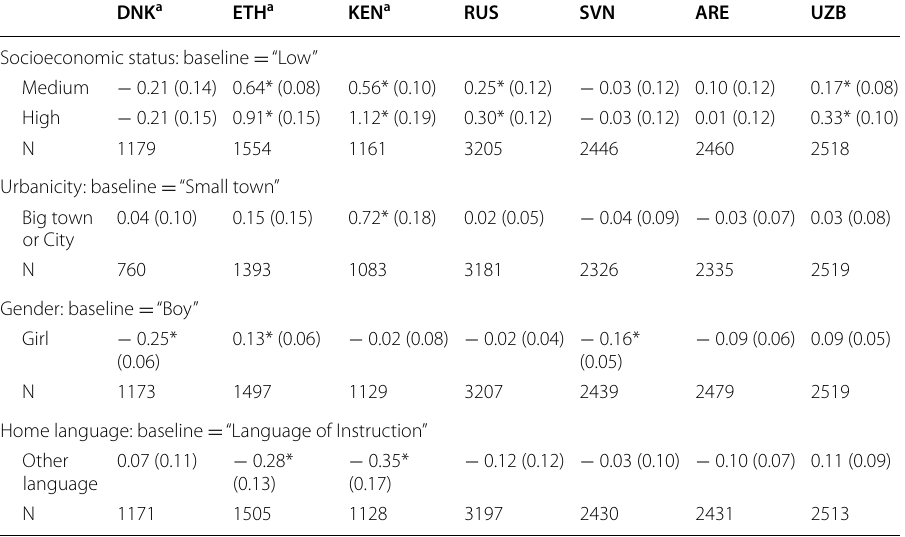
Coefficients for groups come from separate regressions. Standard errors shown in parentheses. Probability weights have been applied and jackknife standard errors have been calculated in all countries except in Denmark, Ethiopia, and Kenya. In Denmark, Ethiopia, and Kenya standard errors have been clustered by school DNK Denmark, ETH Ethiopia, KEN Kenya, RUS Russian Federation, SVN Slovenia, ARE United Arab Emirates, UZB = = = = = = Uzbekistan = a Data may not be representative of target population *p < higher values on the Effective Teachers scale compared to low SES students. Kenya